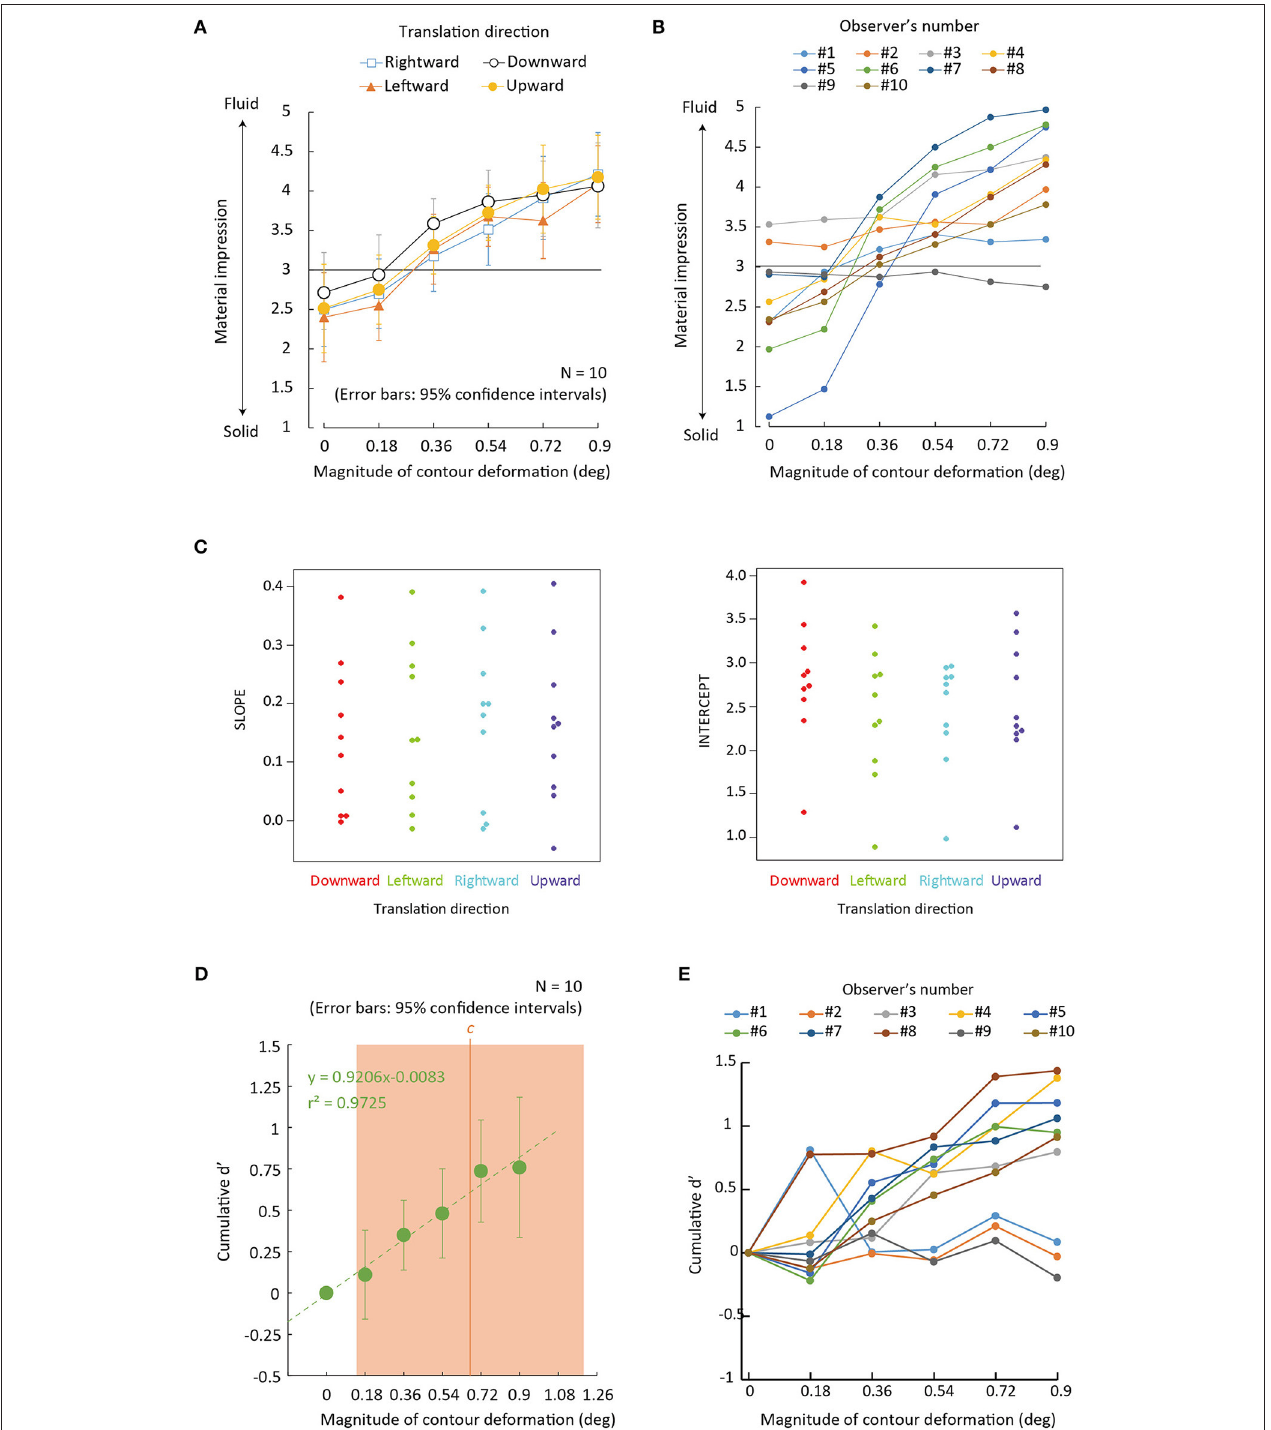
FIGURE 3 | Experiment 1 results. (A) Average rating of material impressions between solid (1) and fluid (5) as a function of the magnitude of contour deformation for each translation direction. Error bars denote 95% confidence intervals ( N = 10). (B) Individual data of (A) wherein the condition of translation direction is collapsed. (C) Beeswarm plots for the Individual slopes and intercepts of a linear function fitted to rating values as a function of the magnitude of contour deformations for each translation direction. (D) Green dots denote cumulative d ′ -value as a function of the magnitude of image deformation with 95 confidence intervals around the mean cumulative d ′ for each level of contour deformation, collapsed across translation directions ( N = 10). An orange vertical line denotes a decision criterion c between rating scores of “3” and “4.” An orange rectangular region denotes 95% confidence intervals around the mean c for each level of contour deformation, collapsed across translation directions ( N = 10). (E) Individual cumulative d ′ as a function of the magnitude of contour deformation.